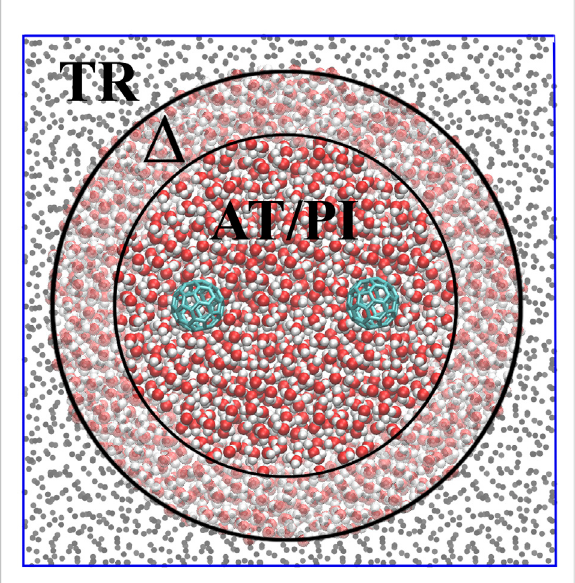
FIGURE 2 Graphical illustration of the AdResS model for the simulation of liquid water solvating two fullerene